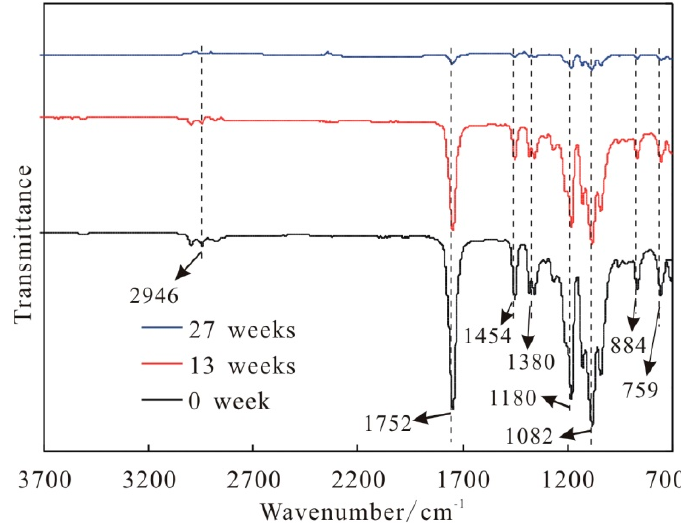
Figure 11. The fourier transform infrared spectra (FTIR) of 1wt% CNTs/PLA sutures at different degradation time points.